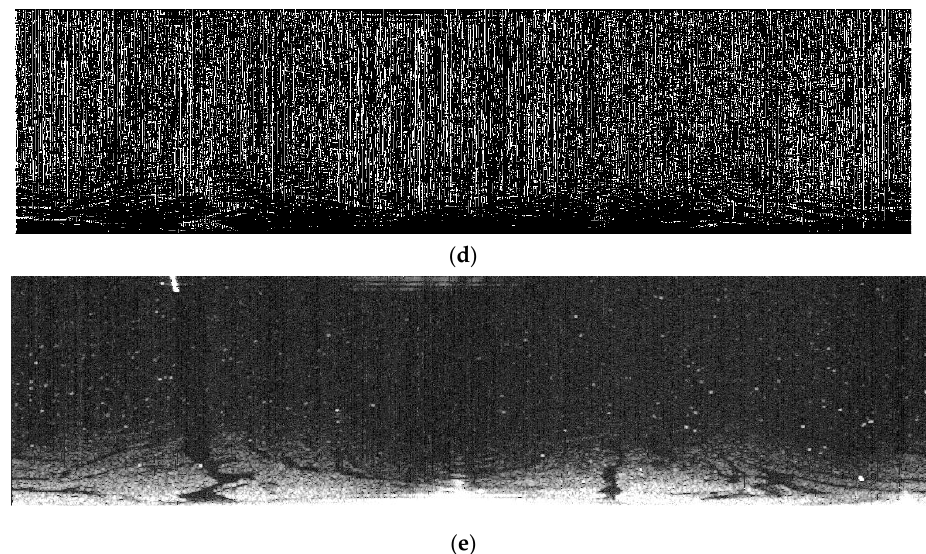
Figure 5. Processed images with co-channel interference removed: ( a ) conventional image with a 7 × 1 filter; ( b ) conventional image with a 1 × 7 filter; ( c ) contrasting image of the two conventional images; ( d ) binarization image with identified co-channel interference; and ( e ) the radar image with co-channel interference removed.